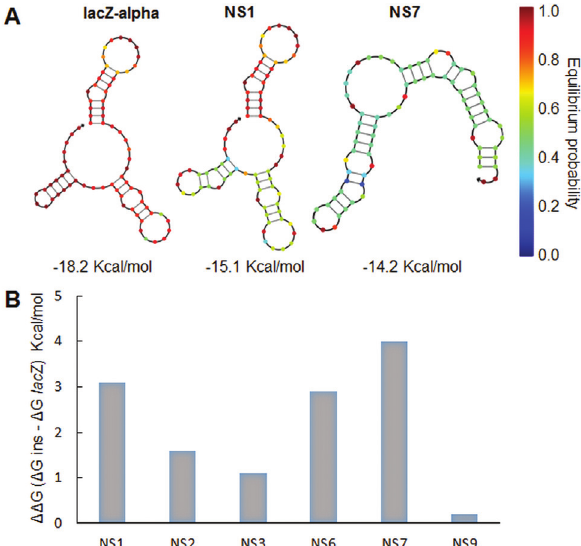
Figure 6 - Recovery of clones with halos correlating to relative decreases infreeenergyoffoldingwhenametagenomicfragmentwasinsertedinthe lacZ gene. A) Thermodynamic analysis at 37 ºC for a dilute solution con- taining the strand species that interact to form the possible ordered com- plexes (RNA secondary structures) using the NUPACK algorithms. For each construct, folding energy was calculated from positions -4 to +70 nt relative to translation start; three example structures are shown. B)